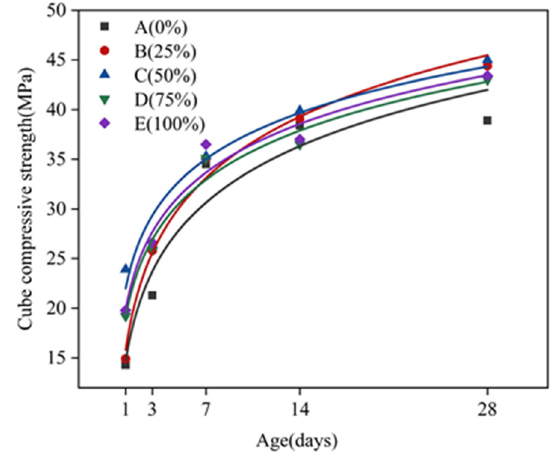
Figure 9. f cu,k -T fitting curve of concrete.